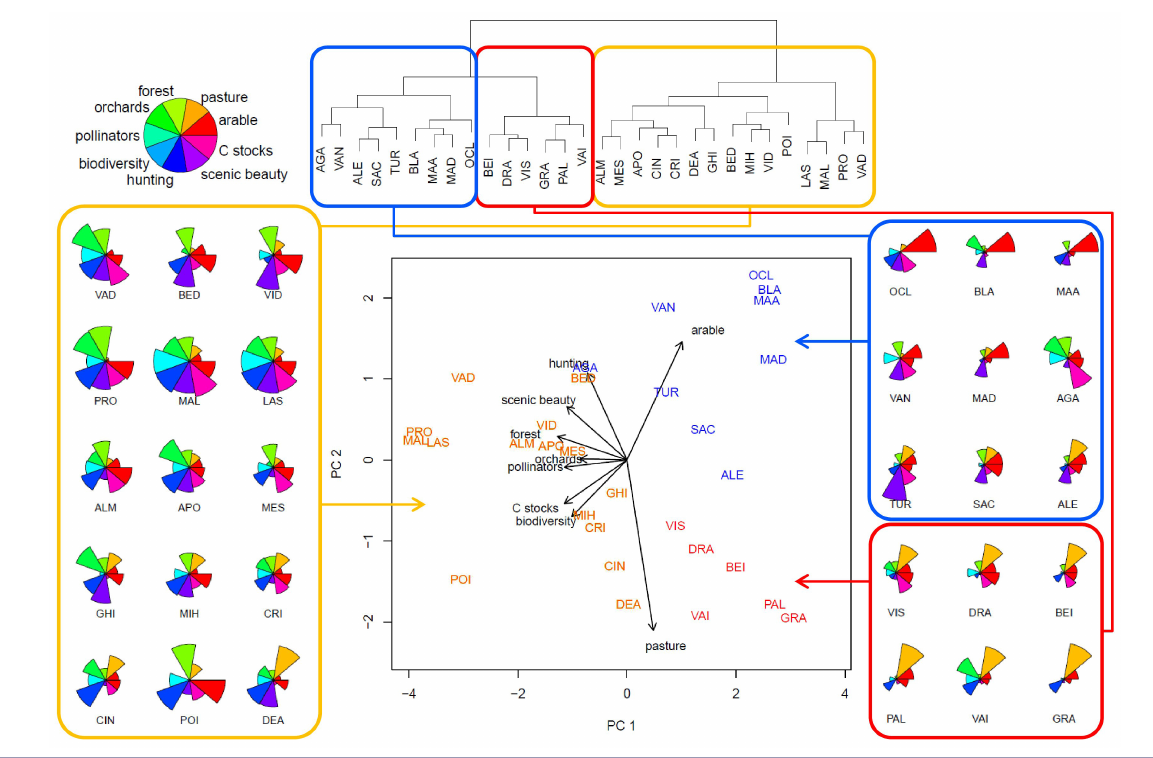
Fig. 3. Statistical classification of the 30 focal villages according to their natural capital assets. Upper panel: Three village types were derived from agglomerative cluster analysis (Wards method on Euclidean distances; agglomerative coefficient: 0.86). Central plot: Principal component analysis of relevant village characteristics (explained variance of axis 1 is 50%, axis 2 is 18%). Flower diagrams: Extent to which different types of natural capital are represented in the different villages. Three main groups of villages are apparent and relate to dominant land use: forest, yellow; arable, blue; pasture,